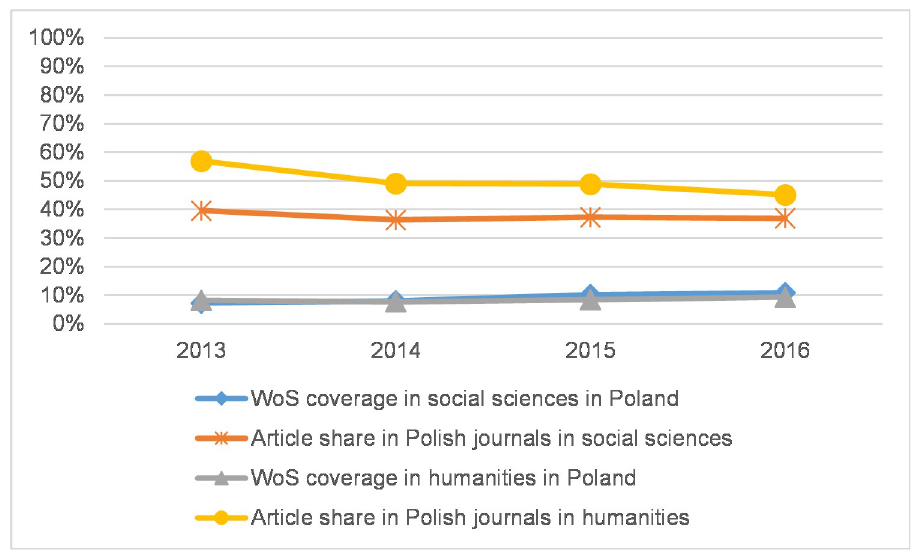
Fig 11. WoS coverage and regional journal article share in